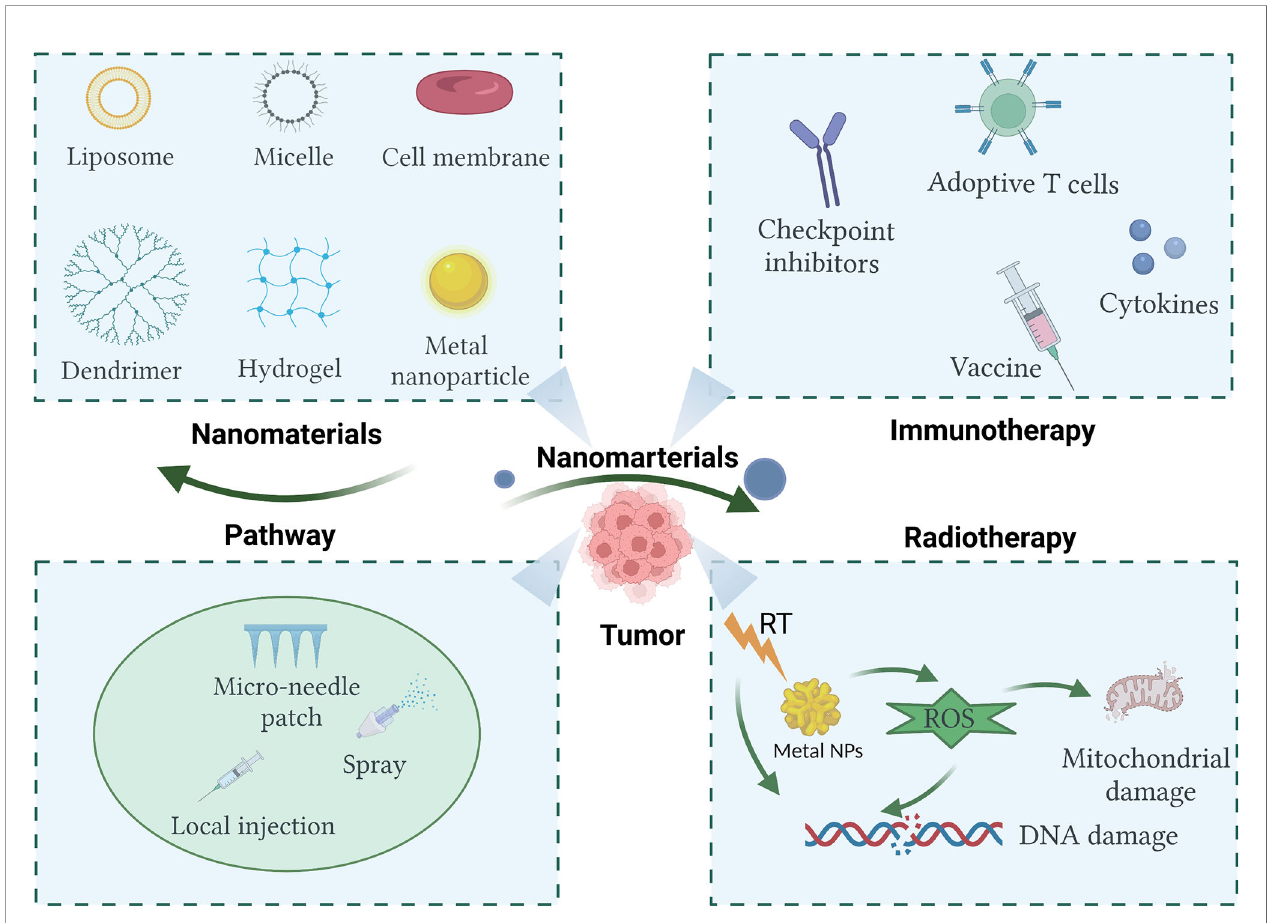
FIGURE 1 | Nanomaterials used in cancer immunotherapy and radiotherapy show promise in enhancing therapeutic ef fi cacy. Created with